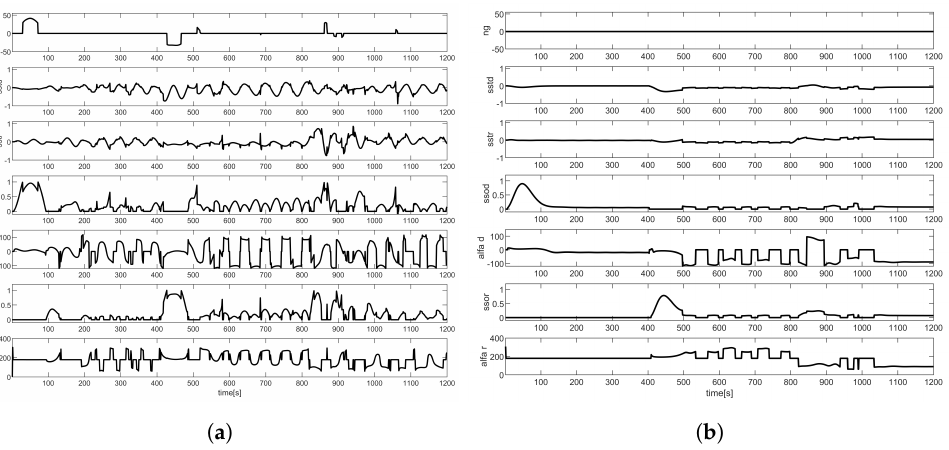
Figure 5. Command diagrams for individual steering and propulsion devices. For two Pareto optimal solutions: ( a ) γ ∞ = 1.1, ( b ) γ ∞ = 2.1. Table 2. Comparison of control quality results obtained for the complex